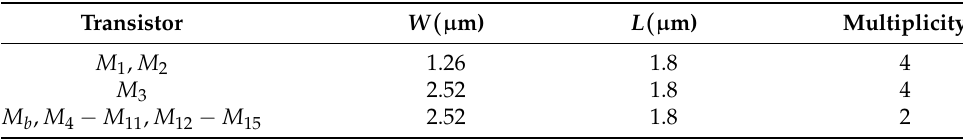
Table 3. Sizes of the OTA shown in Figure 10 to provide a gm = 2 µ A/V.